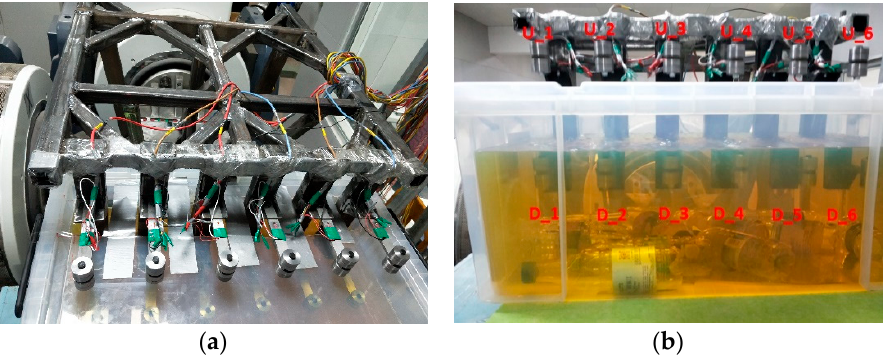
Figure 6. ( a ) Specimen support setup and ( b ) specimen numbering.